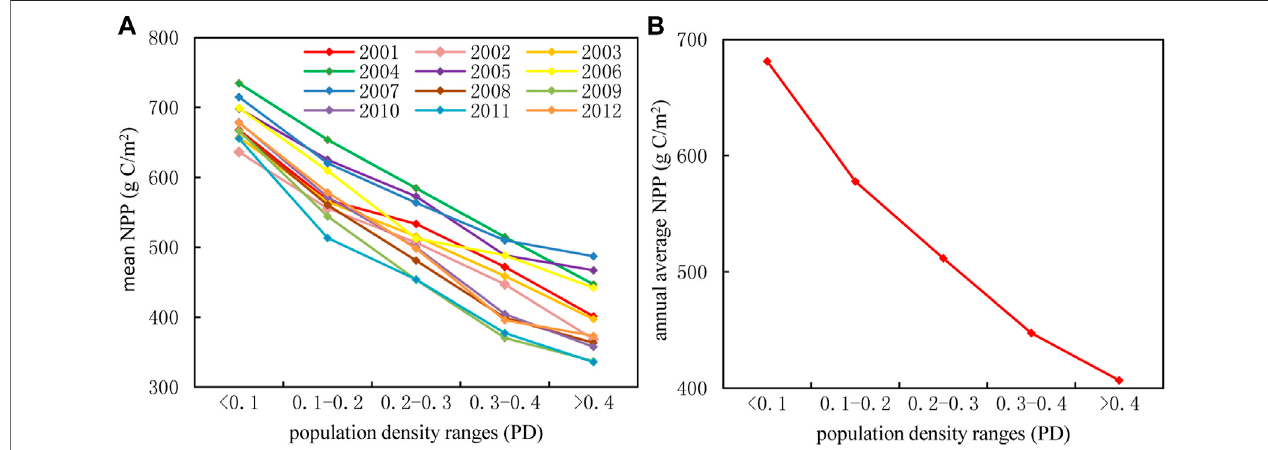
FIGURE9|(A) Spatialdistributionofthe correlations betweenpopulationand annual NPP; (B) correlationcoef fi cients between population and annual NPP for the different population density ranges; and (C) correlation coef fi cients between NPP and population for different land cover types.